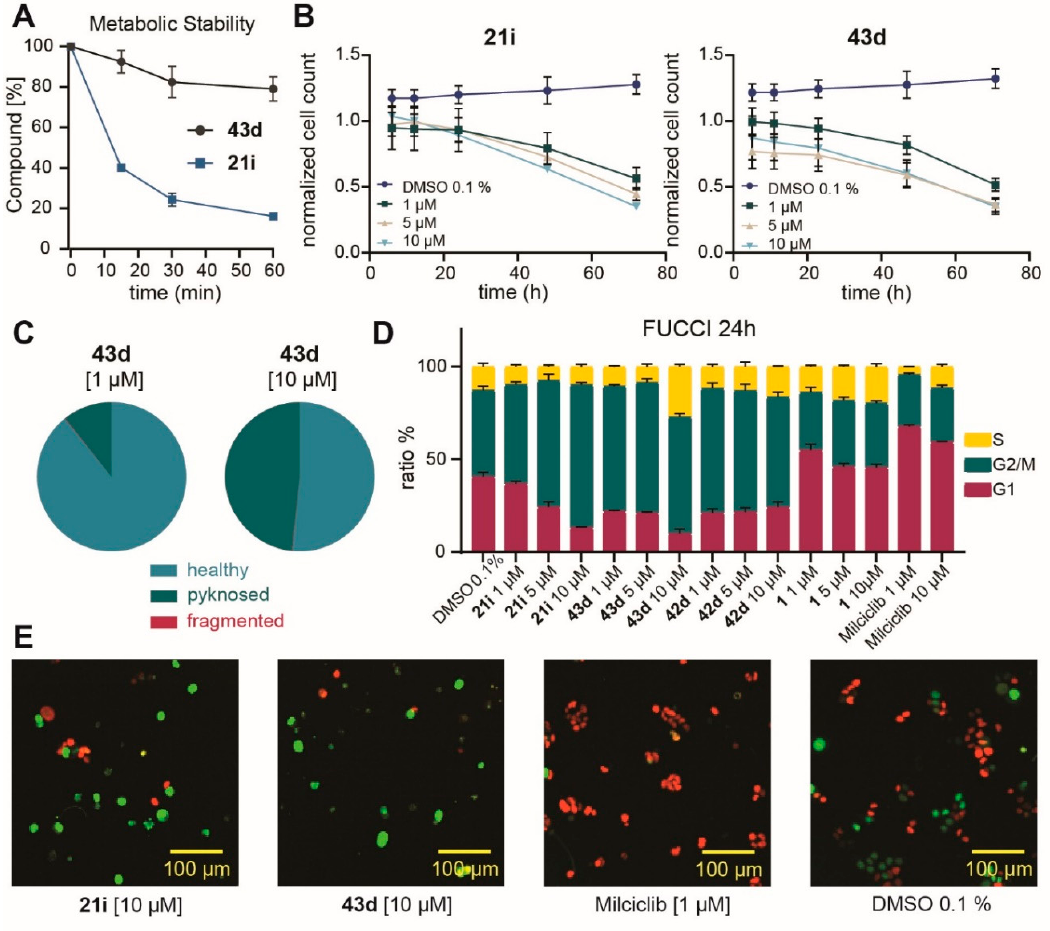
Figure 9. Metabolic stability and cell cycle analysis (FUCCI). ( A ). Metabolic stability of 21i [10 µM] and 43d [10 µM] after treatment of 60 min. The residual amount of compound in percent was plotted against time in minutes. ( B ). Normalized cell count of HCT116-FUCCI cells after 0, 6, 12, 24, 48 and 72 h of compound exposure ( 21i [1, 5, 10 µM], 43d [1, 5, 10 µM]) in comparison to cells exposed to 0.1 % DMSO. Error bars show SEM of two biological replicates. ( C ). Fraction of healthy, fragmented and pyknosed nuclei after 24 h of 1 and 10 µM compound exposure ( 43d ) in HCT116 cells. Average data of two biological duplicates are shown. ( D ). Fractions of red (G1), green (G2/M) or yellow (S) cells after 24 h of compound exposure ( 21i [1 µM, 5 µM, 10 µM], 43d [1 µM, 5 µM, 10 µM], 42d [1, 5, 10 µM], 1 [1, 5, 10 µM], milciclib [1, 10 µM]) in comparison to cells exposed to 0.1 % DMSO. Error bars show SEM of two biological replicates. ( E ). Fluorescence Image of HCT116-FUCCI cells after 48 h of compounds exposure ( 21i [10 µM], 43d [10 µM]) in comparison to cells exposed to milciclib [1 µM] and cells exposed to 0.1 % DMSO.